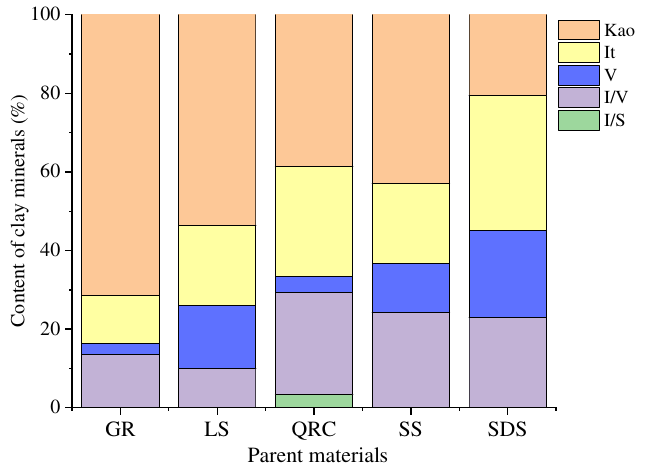
Figure 3. Relative content of clay minerals of studied upland soils derived from different parent materials (Kao: kaolinite; It: illite; V: vermiculite; I/S: illite/smectite mixed-layer mineral; I/V: illite/vermiculite mixed-layer mineral; GR: granite; LS: limestone; QRC: Quaternary red clay; SS: slate and shale; SDS: